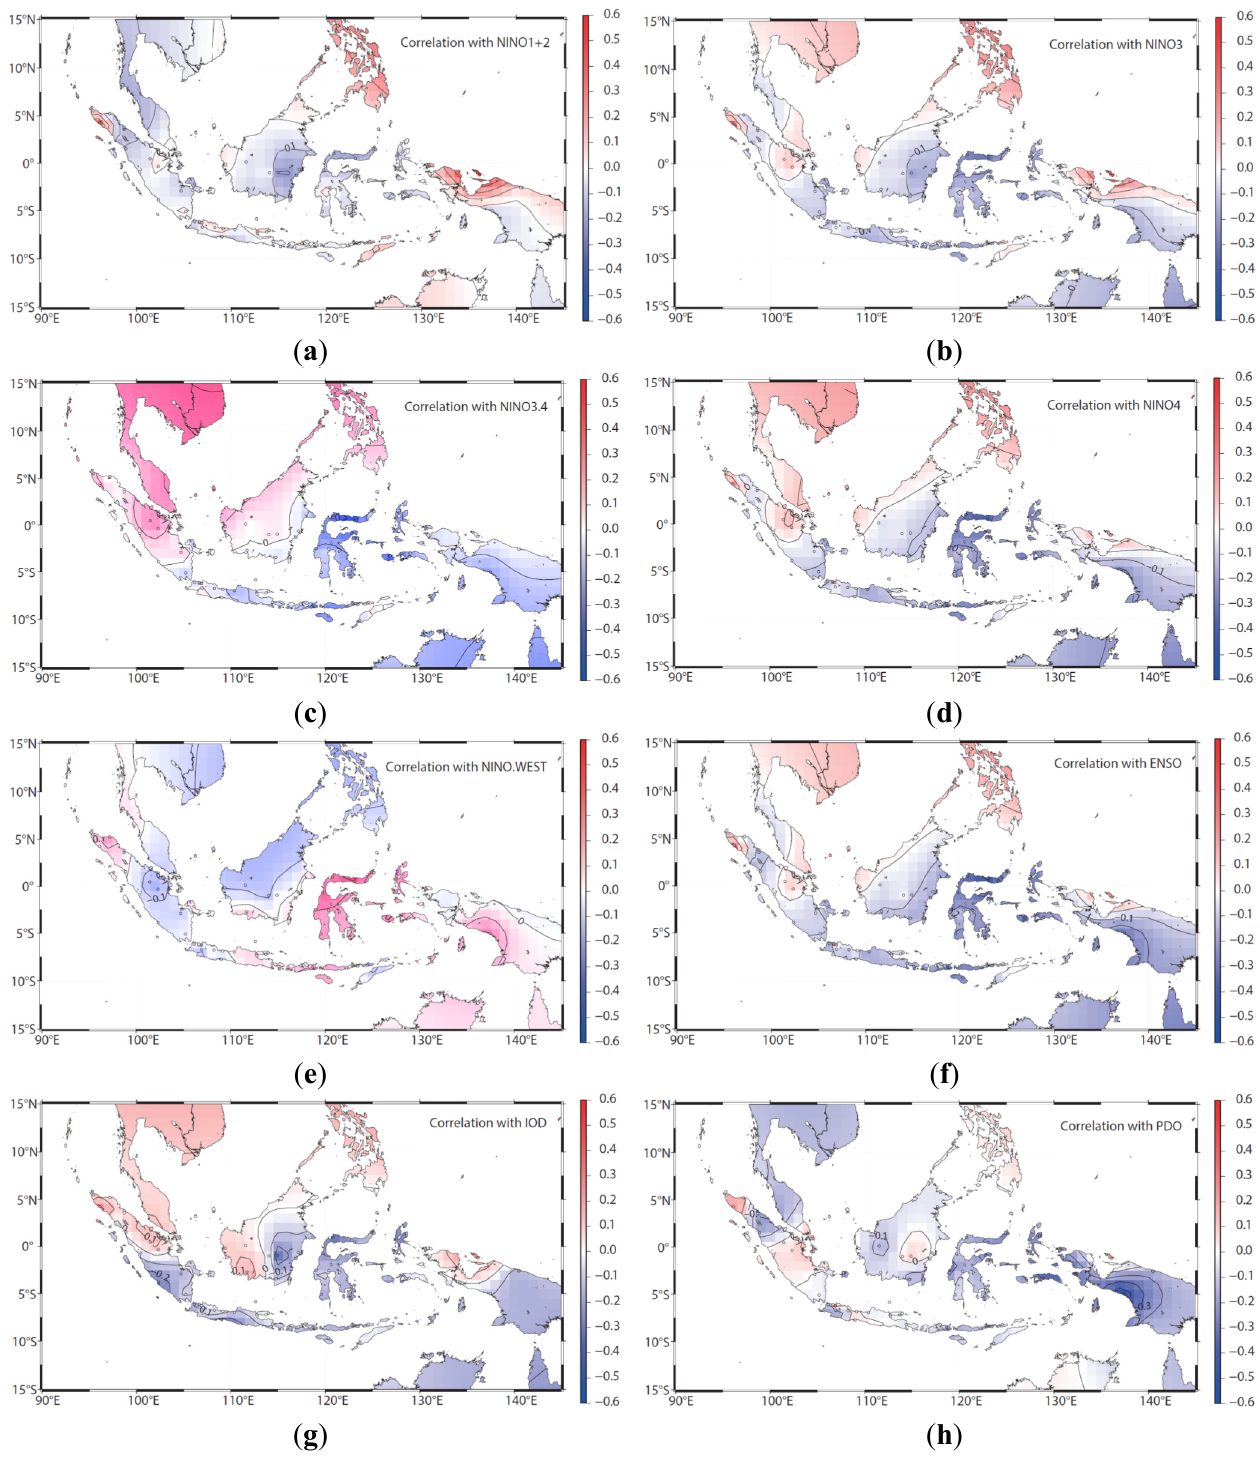
Figure 5. Spatial correlations over Indonesia between the five-month running means of the precipitation data and the indices: ( a ) NINO1 + 2; ( b ) NINO3; ( c ) NINO3.4; ( d ) NINO4; ( e ) NINO.WEST; ( f ) ENSO; ( g ) IOD and ( h )